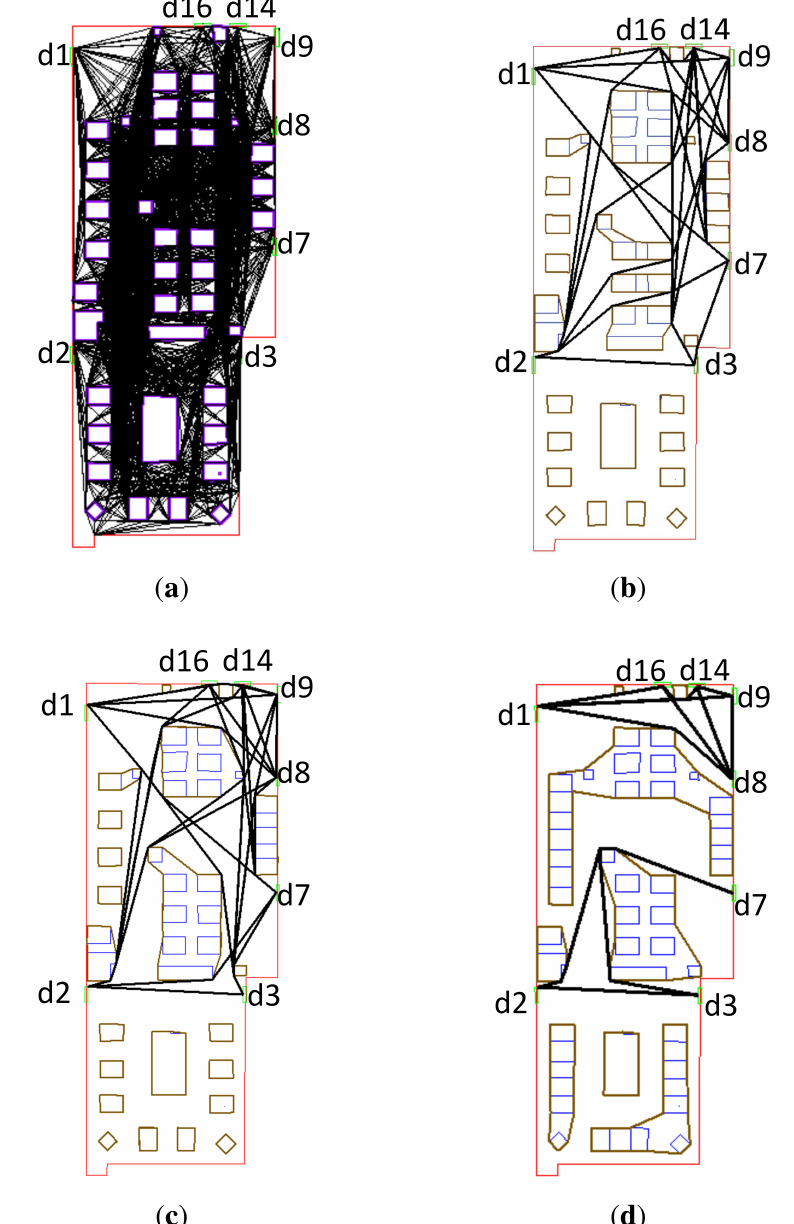
Figure 17. ( a ) The VG regardless of a user’s dimension and ( b – d ) all of the shortest paths between all doors for the sizes of 0.5 m, 0.6 m and 0.8 m. (a) The complete VG of all obstacles without respect to a user’s dimension; (b) all of the shortest paths for the user with a size of 0.5 m; (c) all of the shortest paths for a user with a size of 0.6 m; (d) all of the shortest paths for the user with a size of 0.8